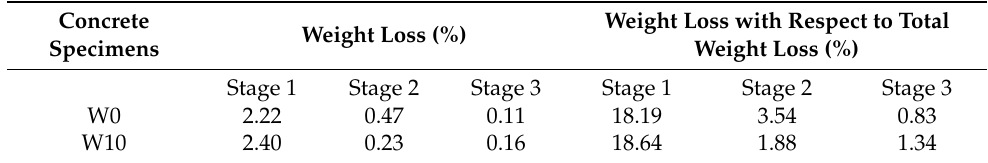
Table 6. Weight loss values of W0 and W10 mortar at 90 days [86].